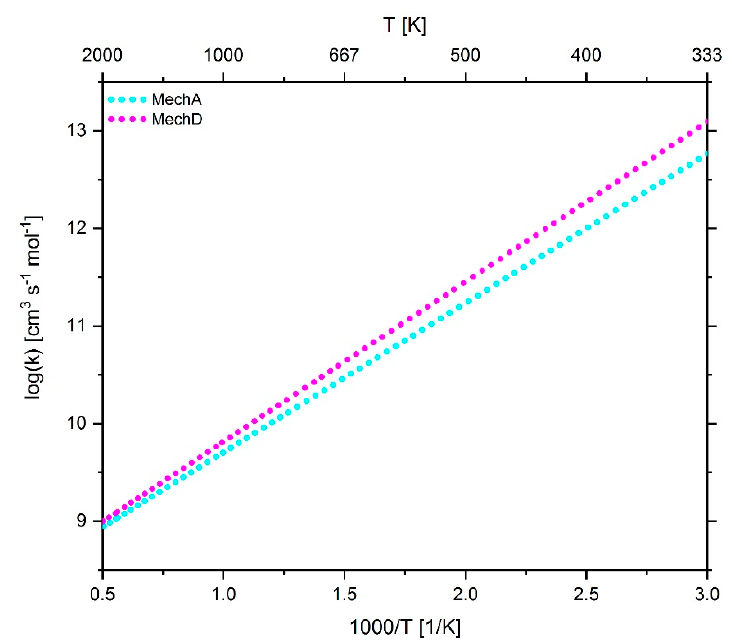
Figure 15. Comparison of the reaction rate coefficient of reaction 247 (C 3 H 6 OOH + O 2 ↔ OC 3 H 5 OOH + OH) of MechA and MechD.